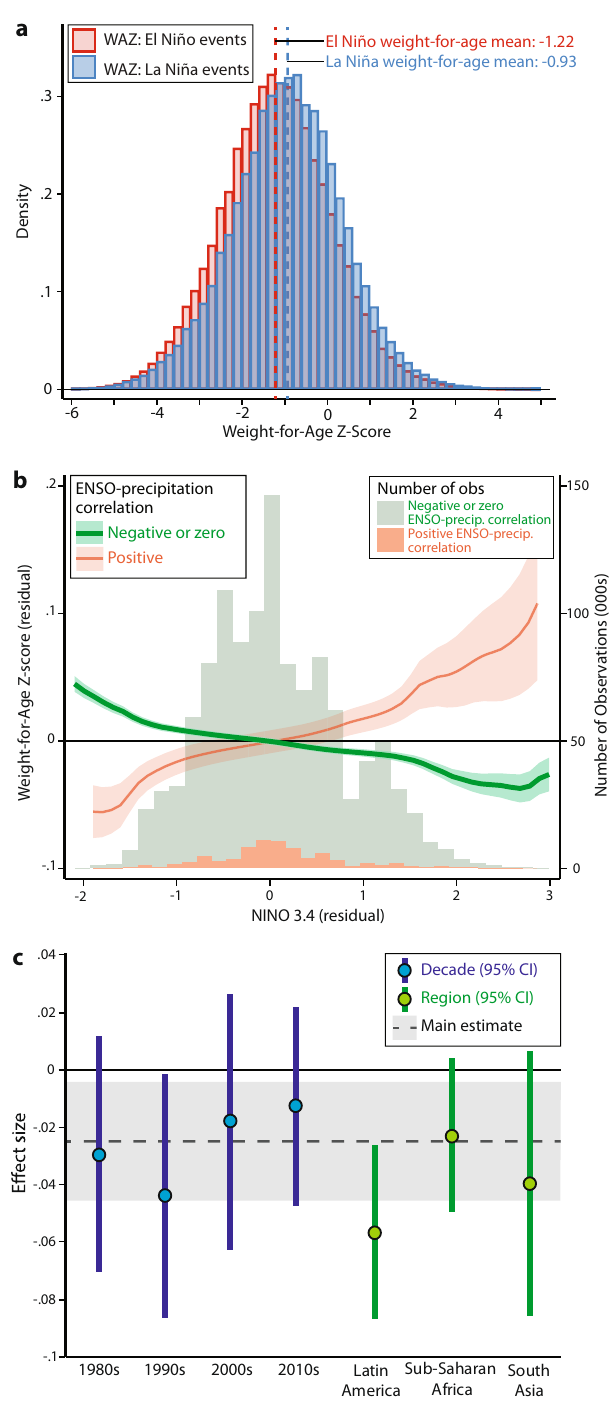
z -scores and negative deviations from the mean ENSO state (La